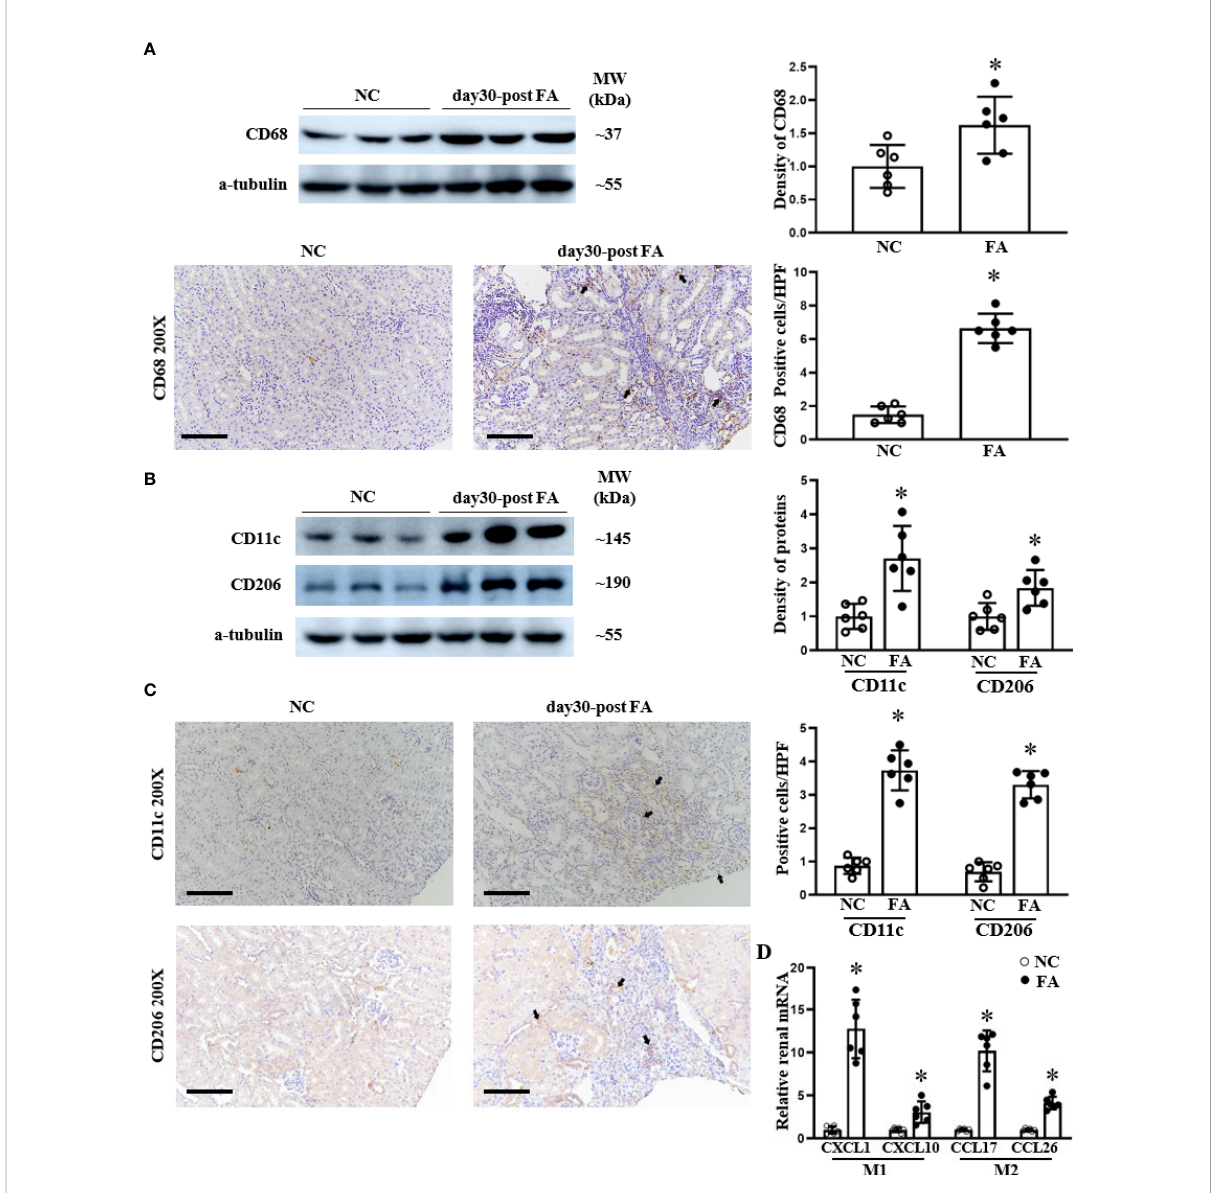
FIGURE 5 The in fi ltration of total macrophages, M1 macrophages, and M2 macrophages increased in the kidneys of renal interstitial fi brosis mice. Western blots and immunohistochemical (IHC) staining of the renal expression of CD68 protein, a typical biomarker for total macrophages (A) , are shown. M1 macrophage polarization is indicated by CD11c, and M2 macrophage polarization is indicated by CD206 expression as analyzed using Western blotting (B) and IHC staining and their respective semi-quanti fi cation (C) . The renal mRNA levels of M1-related